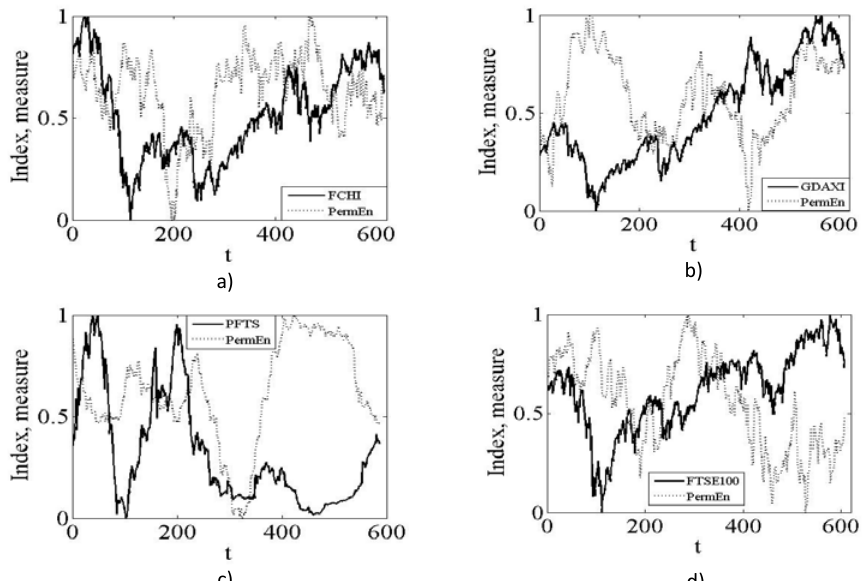
Fig. 3: Comparative dynamics of output series and permutation entropy for stock markets: (a) France, (b) Germany, (c) Ukraine, (d) the United Kingdom